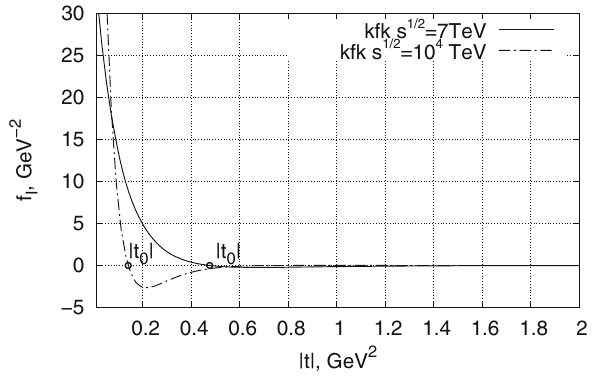
Fig. 3 The t -dependence of f I at 7 and at 10 4 TeV (the kfk-model). The positions of zeros are